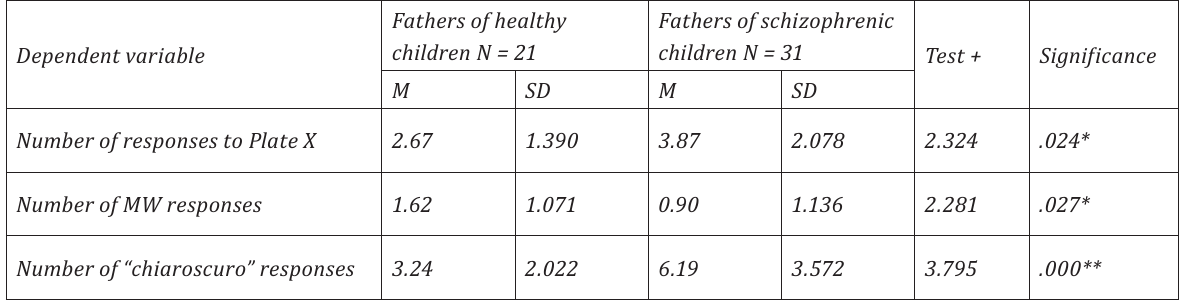
Table 5. Differences and the significance of differences in terms of selected variables between the group of fathers of healthy children and the group of fathers of schizophrenic children